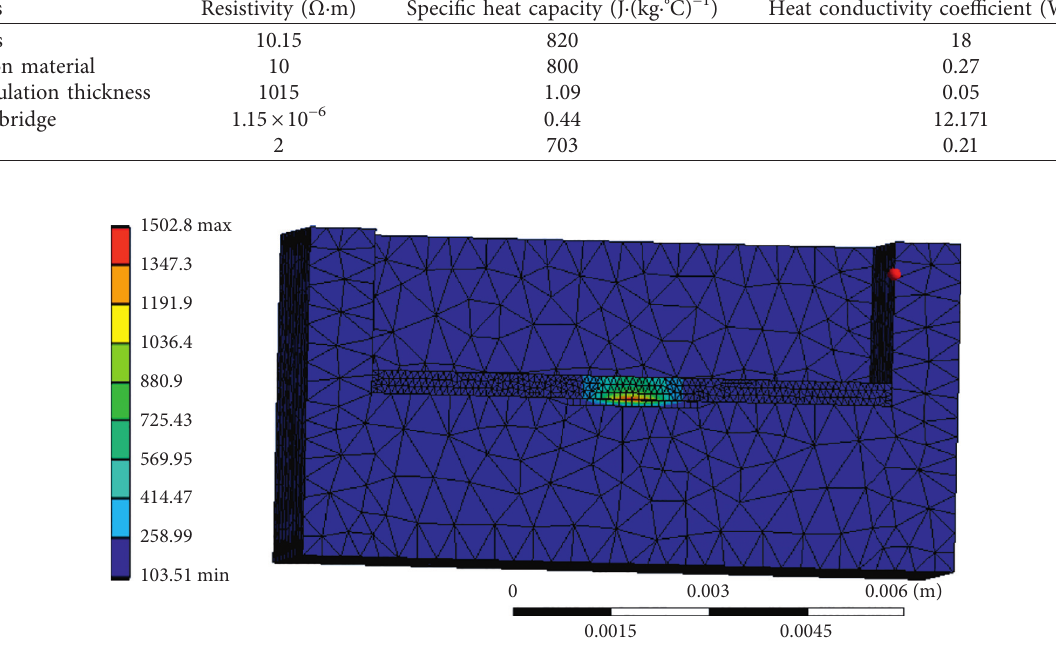
Figure 6: Temperature distribution of electrothermal simulation.